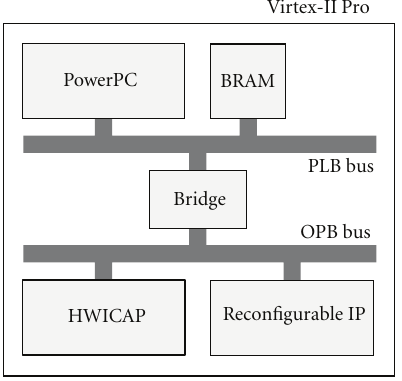
Figure 7: Virtex II Pro run-time reconfigurable platform.